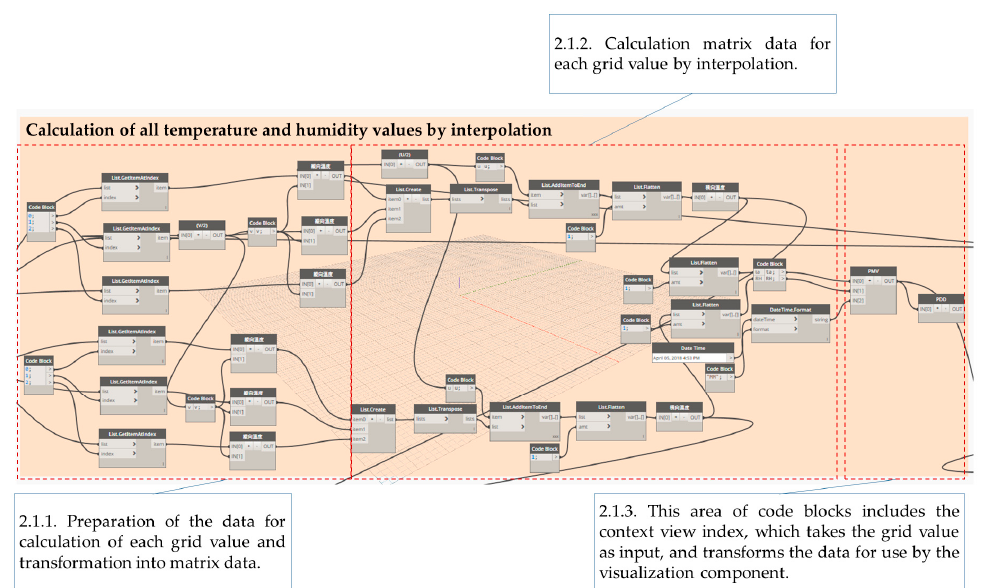
Figure 8. Calculation of grid data by interpolation.